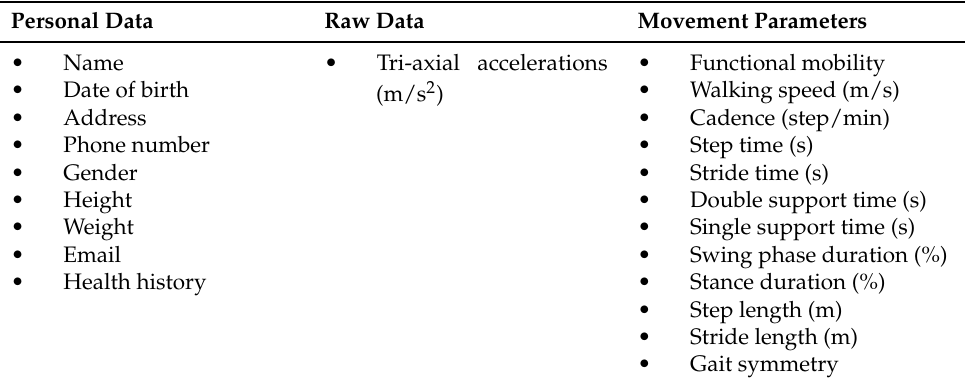
Figure 6. iT10M test. Note the sensor is located on the lower-back of the person. The algorithm for gait analysis used and validated by the research team [27] allows processing the tri-axial accelerometry signals from the lower back. During the execution of the gait test, these data permit identifying the events of initial contact and final contact of each foot and, in this way, identifying the main gait events. With such data, it is possible to extract the spatio-temporal parameters of the gait cycle from each limb: Cadence (step/min), step time (s), stride time (s), double support time (s), single support time (s), swing phase duration (%), stance duration (%), step length (m), and stride length (m). Table 3 summarises the information that can be obtained using the proposed system. Table 3. Available information in the proposed movement analysis system by the instrumentation of the iT10M for gait